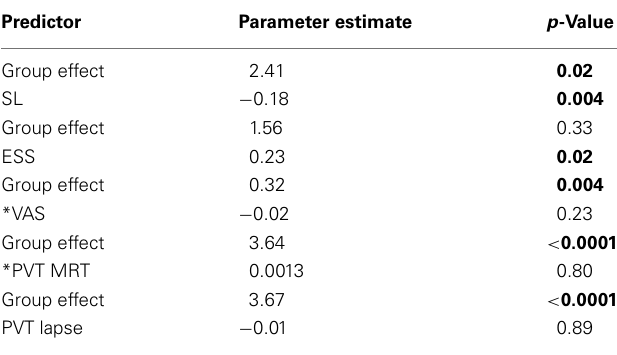
Table 3 | Prediction of PUI by group and other